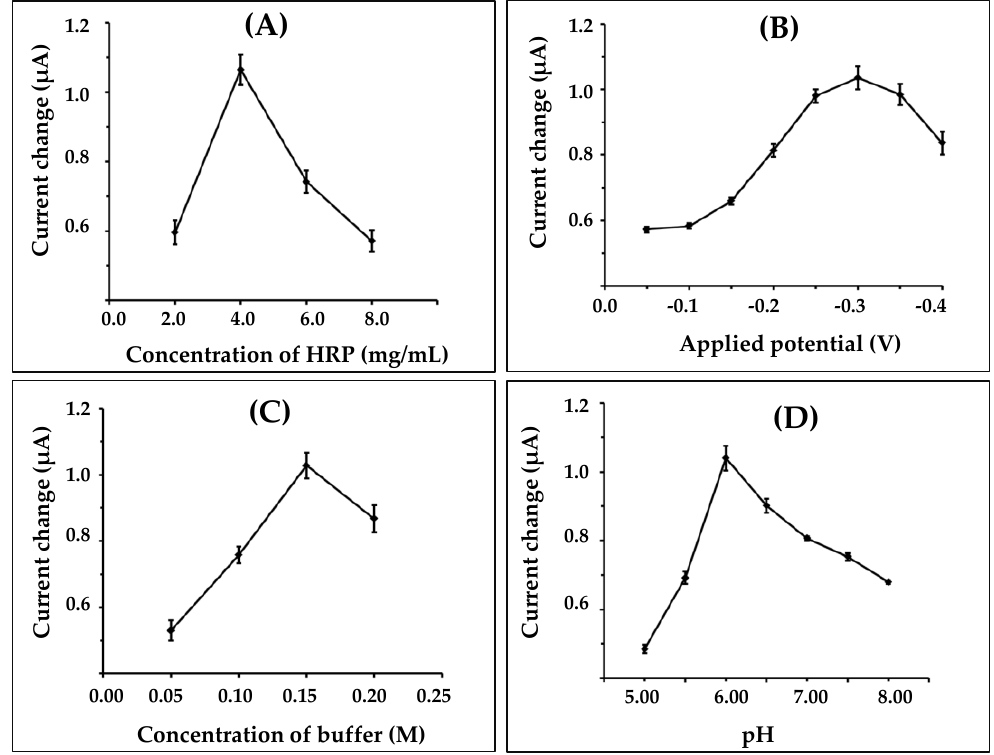
Figure 4. Effect of ( A ) concentration of HRP; ( B ) applied potential; ( C ) concentration of buffer; and ( D ) pH on the response current of the nanofiber electrode.